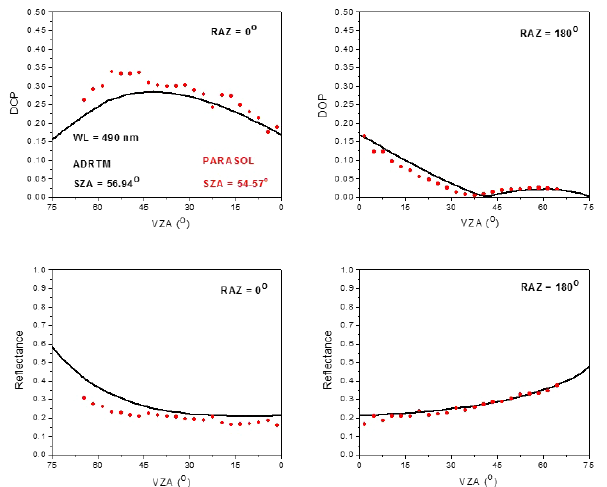
Figure 5. Comparison of the modeled DOP and reflectance of desert-reflected solar light at RAZs of 0 and 180 ◦ with those from the PARASOL data at the wavelength of 490nm. The SZA is 56.94 ◦ in the modeling. The SZA is in the bin of 54–57 ◦ for the PARASOL data.